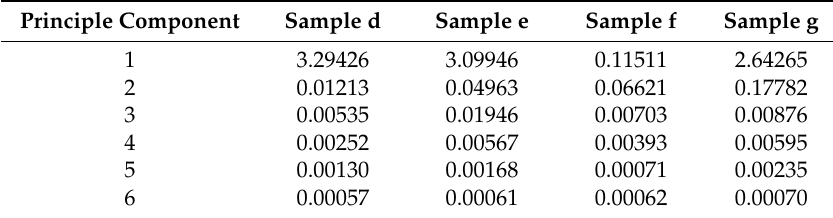
Table 2. Contribution of principal components for four different mixed samples.